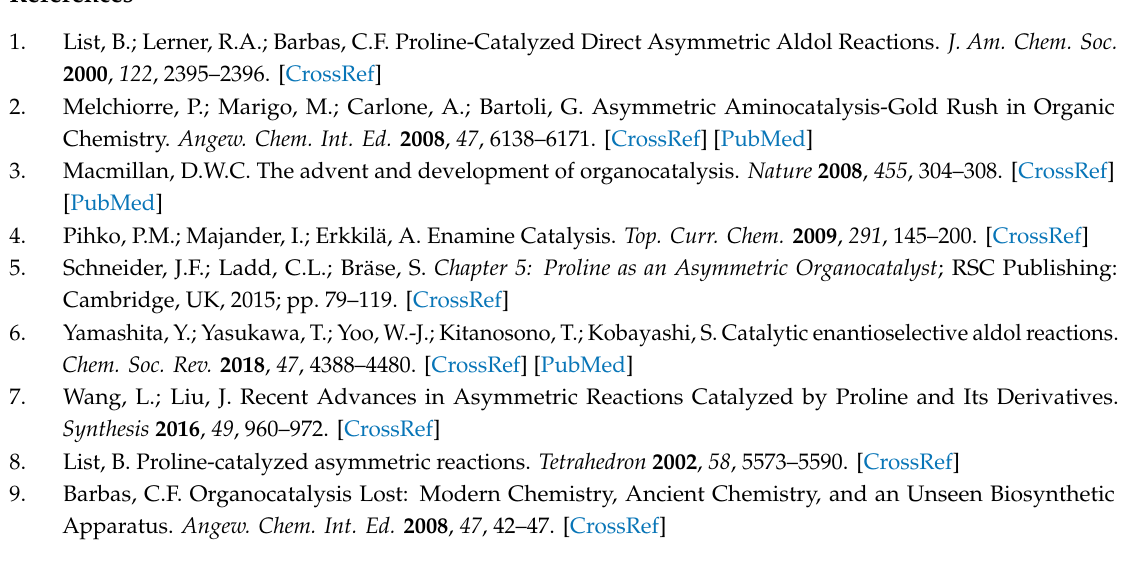
Table S1: Enantioselectivity variation as a function of reaction time; Figure S1: 1 H-NMR spectrum of commercial proline; Figure S2: 1 H-NMR spectrum of recovered proline employing work-up method C (Table 8); Figure S3: 1 H-NMR spectrum of recovered proline employing work-up method D (Table 8), CSP-HPLC separation conditions and chromatograms of aldols 3 (racemic and enantio-enriched), full characterization of anti aldol product 3ad (CSP-HPLC chromatogram of enantio-enriched product, 1 H-NMR spectrum, 13 C-NMR spectrum, HPLC-MS chromatograms, ESI-MS